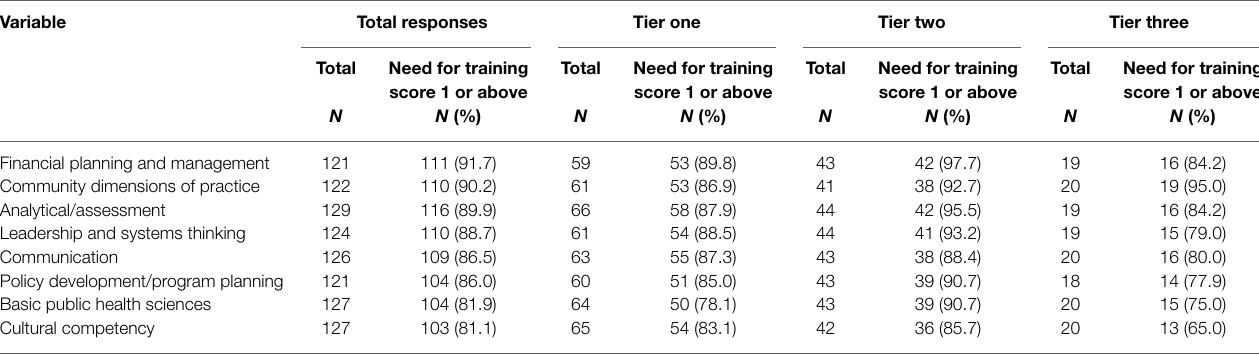
TABLE 3 | Proportion of respondents with a need for training across domains and tiers .